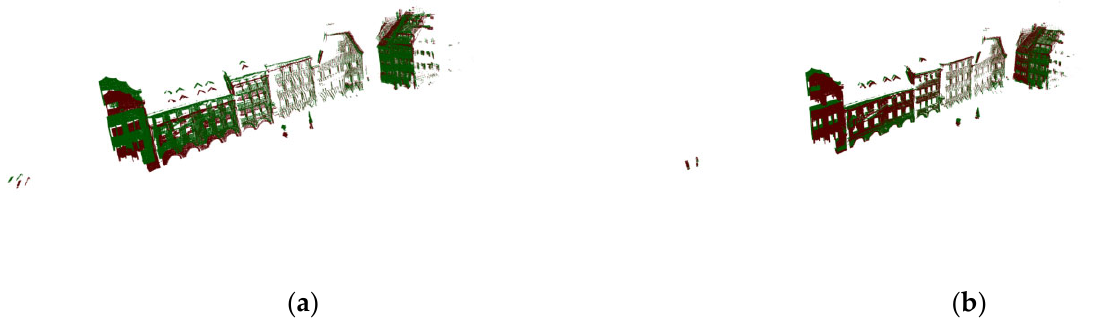
Figure 14. The registration effect corresponding to ( a ) 588 iterations and ( b ) 1412 iterations.